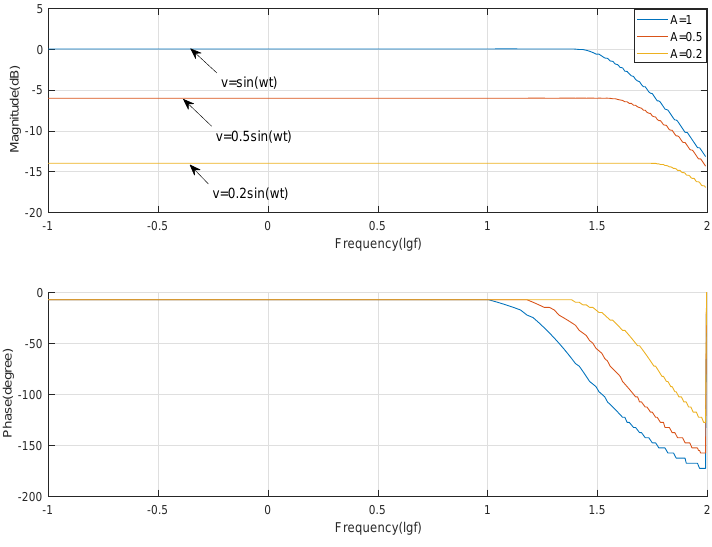
Figure 8. Bode diagram of the tracking differentiator